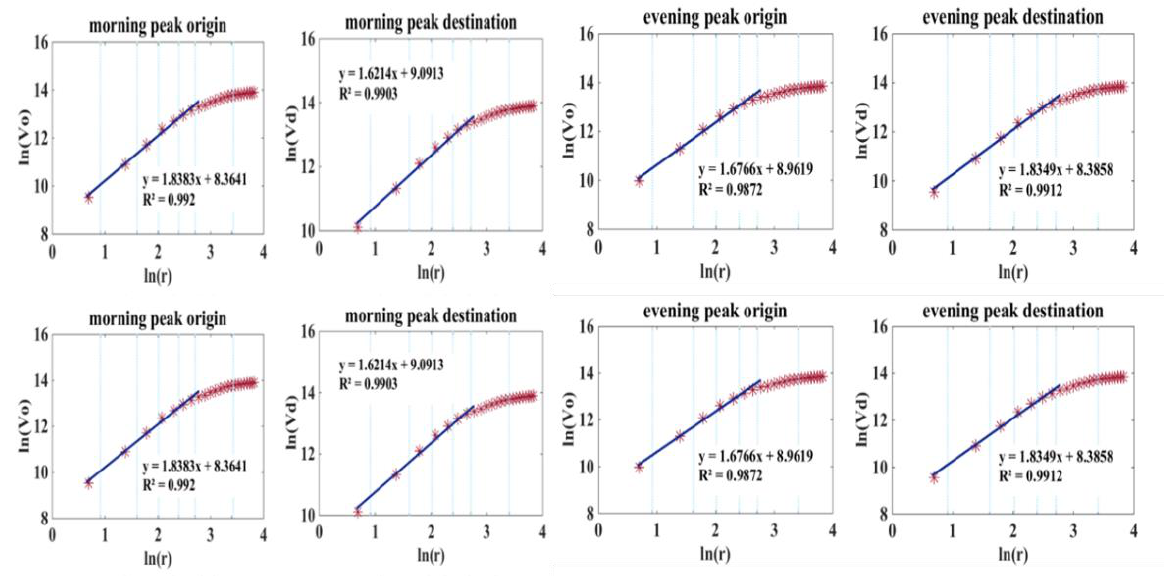
Figure 14. Volume dimension of mobile phone ODs.